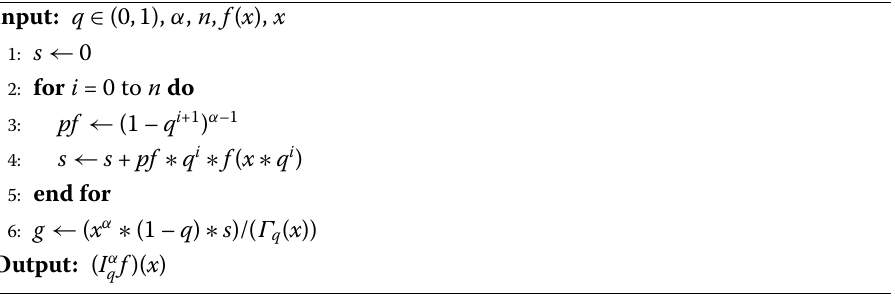
Algorithm 4 The proposed method for calculated ( I α